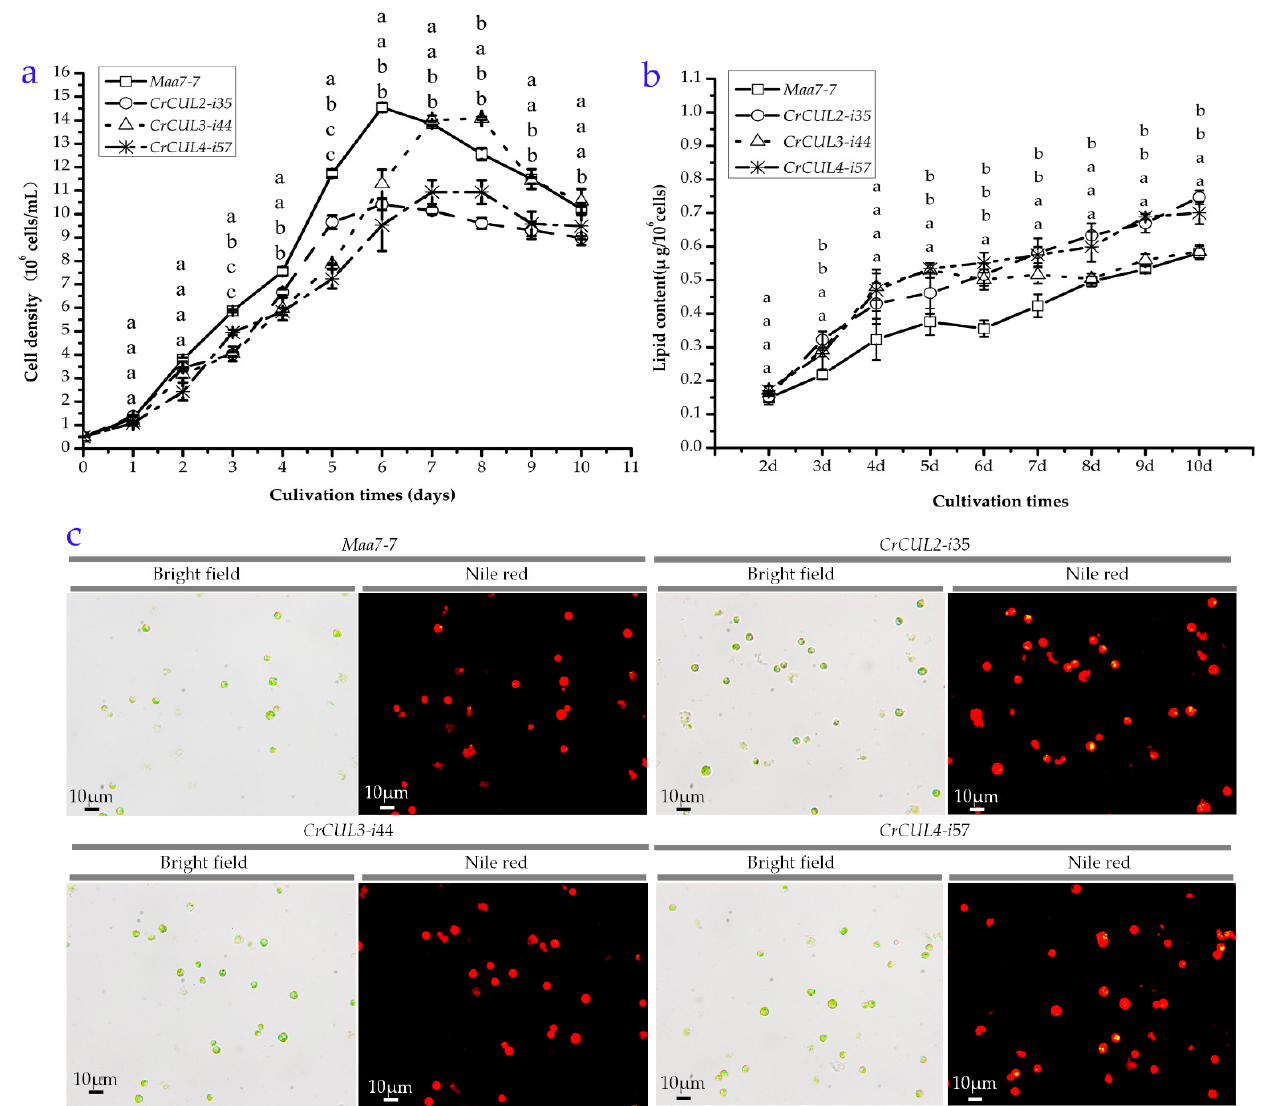
Figure 5. The growth and lipid accumulation of CrCUL RNAi lines. ( a ) The growth curve of CrCUL RNAi lines. Different letters indicate significant differences ( p ≤ 0.05) by Dunnett’s multiple range test. ( b ) Total lipid contents of CrCUL RNAi lines. The lipid content of each strain was normalized to cell densities quantified at the growth phase. The data are representative of three replicas and different letters indicate significant differences ( p ≤ 0.05) by a one-way ANOVA. ( c ) TAG disturbers in CrCUL RNAi lines and the control. Cells were grown in an HSM medium for 10 days. Lipid bodies were stained with Nile red (yellow dots) and imaged by fluorescence microscopy. Bar = 10 µm.